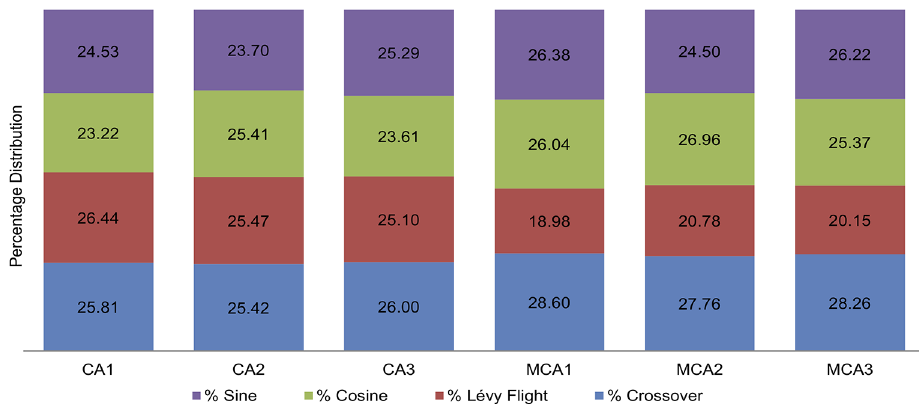
Fig 10. Average search operator percentage distribution for Table 3.